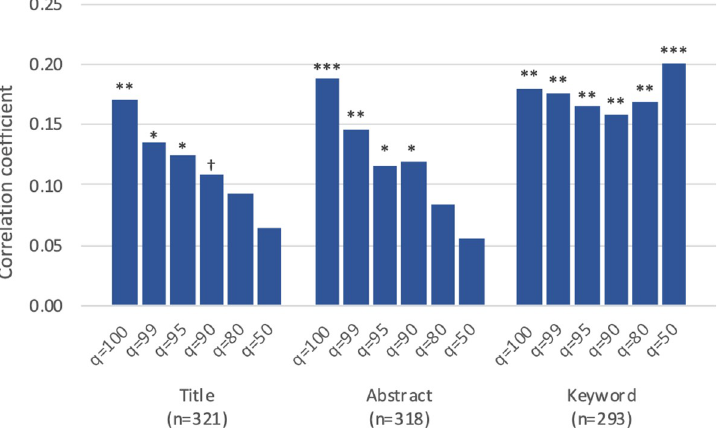
Fig 3. Correlation between bibliometric and self-reported novelty measures. Pearson’s correlation coefficient. Novel q ( q 2 {100,99,95,90,80,50}) is correlated with the mean of four self-reported newness scores (Column 9 in Table 4). † p < 0.1, � p < 0.05, �� p < 0.01, ��� p < 0.001.